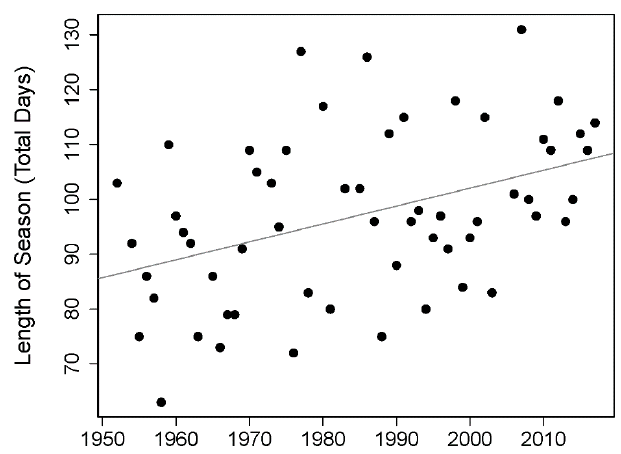
Figure 3. Length of the summer stressful season for Z. marina over time. y = 0.33x – 551; p < 0.01; r 2 = 0.16.